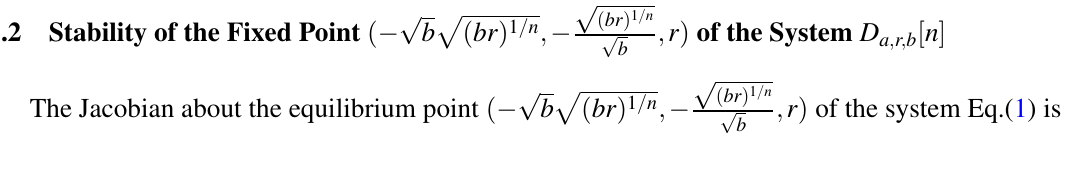
−√ −√ (cid:112) ( br ) 1 / n b ( br ) 1 / n , , r ) of the System D [ n ] √ a , r , b b −√ √ (cid:112) ( br ) 1 / n b ( br ) 1 / n , , r ) of the system Eq.(1) √ b